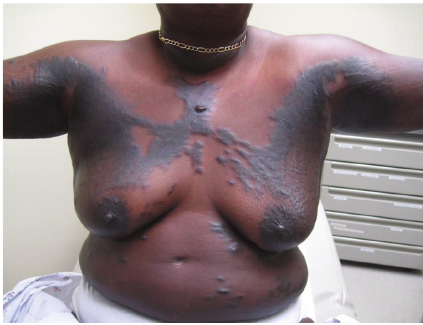
Figure 1: Keloidal scleroderma. Multiple, scattered, and hyper- pigmented nodules overlying plaques along the trunk and upper extremities.